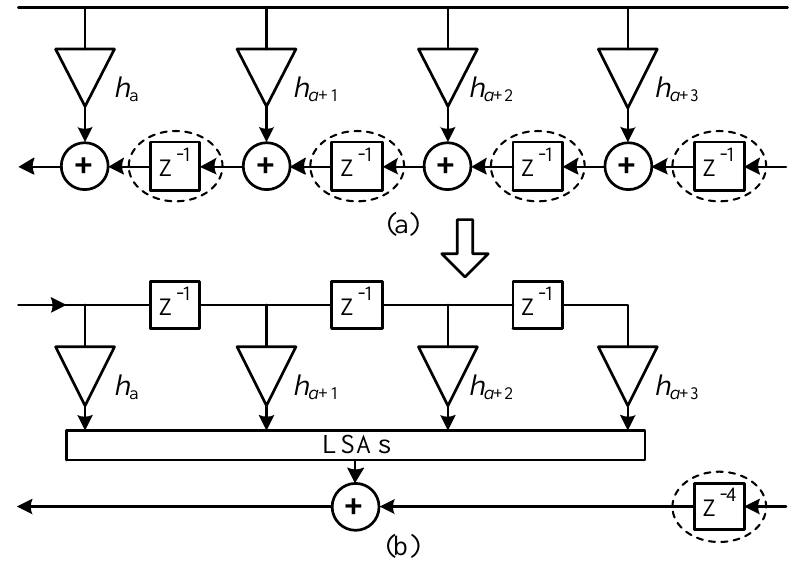
Figure 7. Transformation from the TDF structure to the hybrid